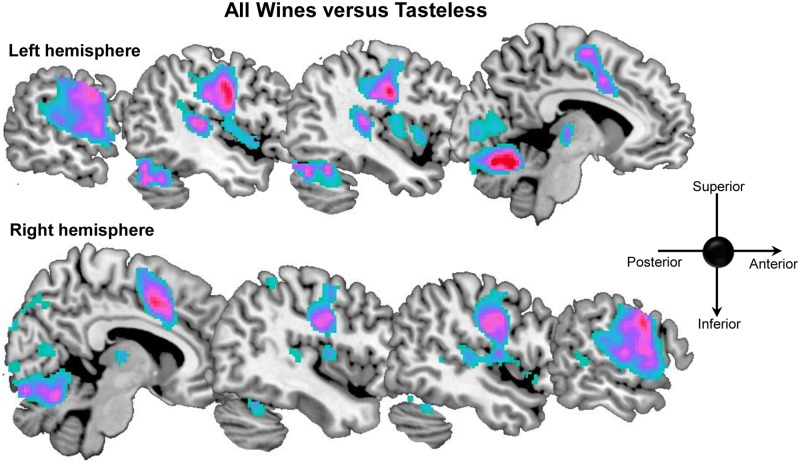
Sagittal view of brain activation for the contrast all wines vs. tasteless.